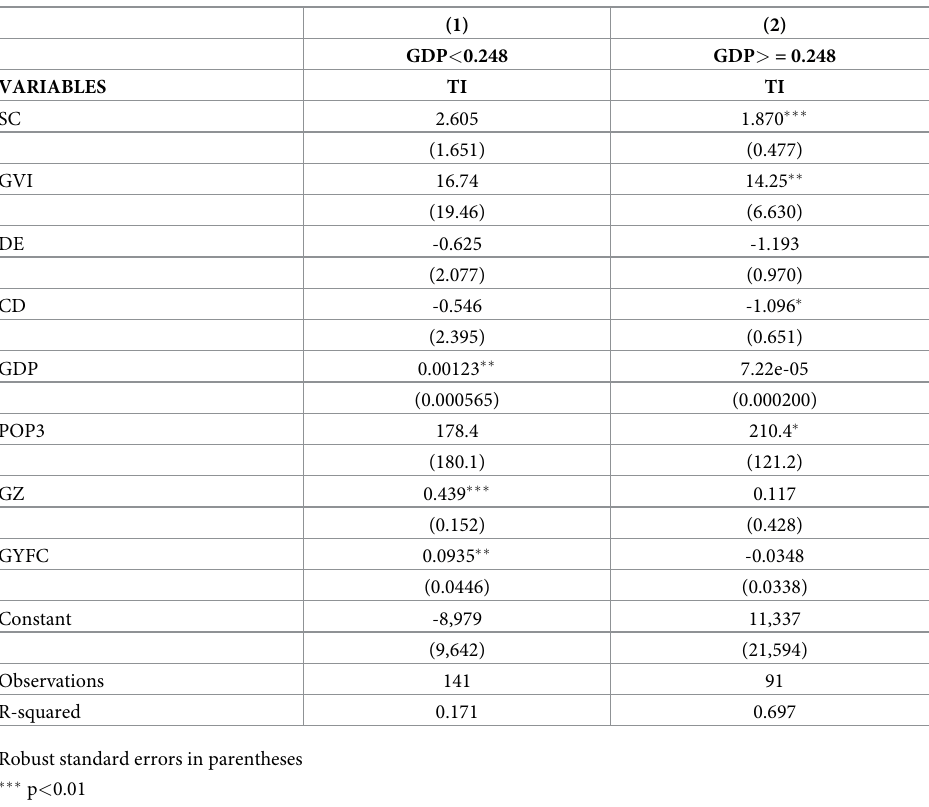
Table 7. Threshold